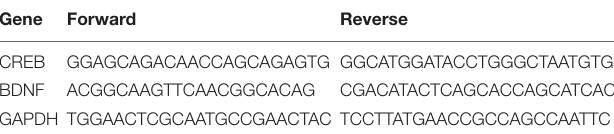
phosphate buffered saline throughout one night. Transverse spinal cord (20 m) and ACC (20 m) slices were produced for immunofluorescence staining using a cryostat (Leica, CM1950). After washing with PBS, the sections were blocked for 1 h at 37 ◦ C with 5% goat serum in 0.3 percent Triton X-100 and incubated overnight at 4 ◦ C with the primary antibody. The sections were treated for 2 h at 37 ◦ C